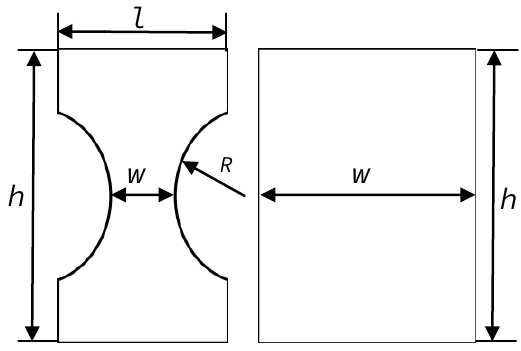
Figure 6. Specimens ’ shape designs. Figure 6. Specimens’ shape Table 2. Specimen sizes.